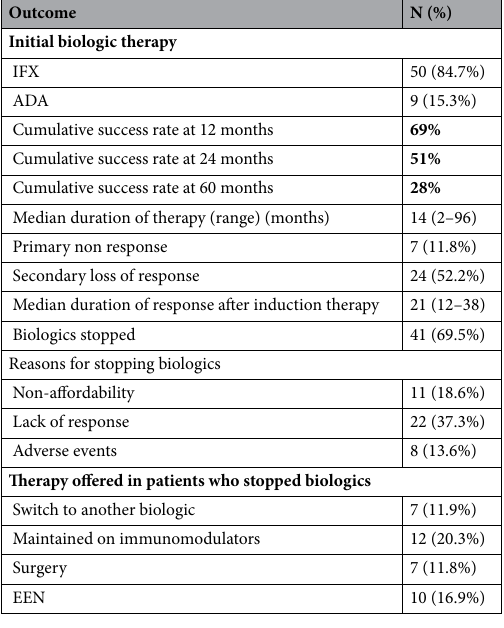
Table 2. Outcomes after initiation of biological therapy in stricturing Crohn’s disease.